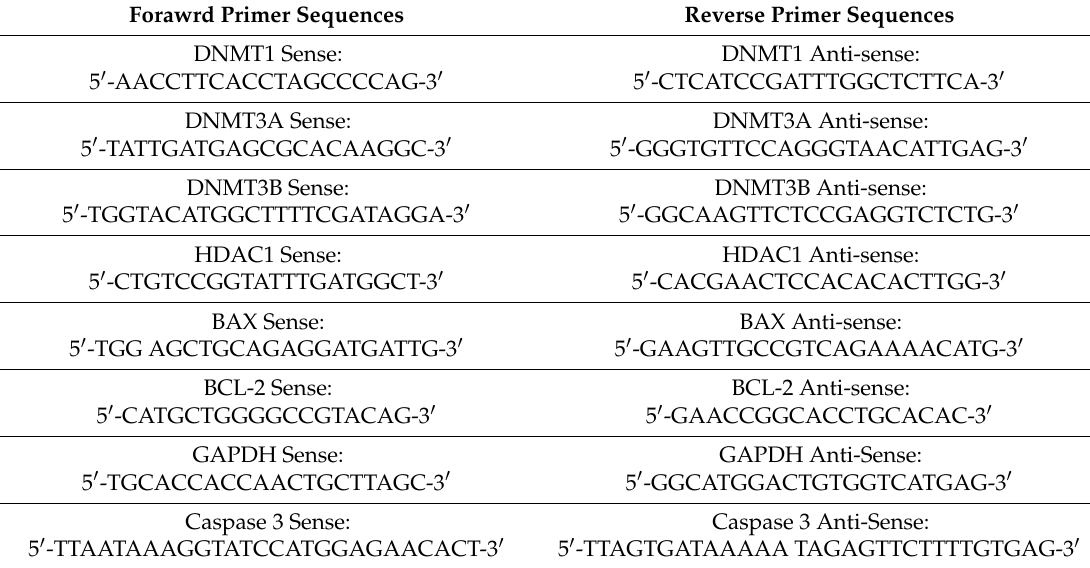
Table 2. qRT-PCR primer